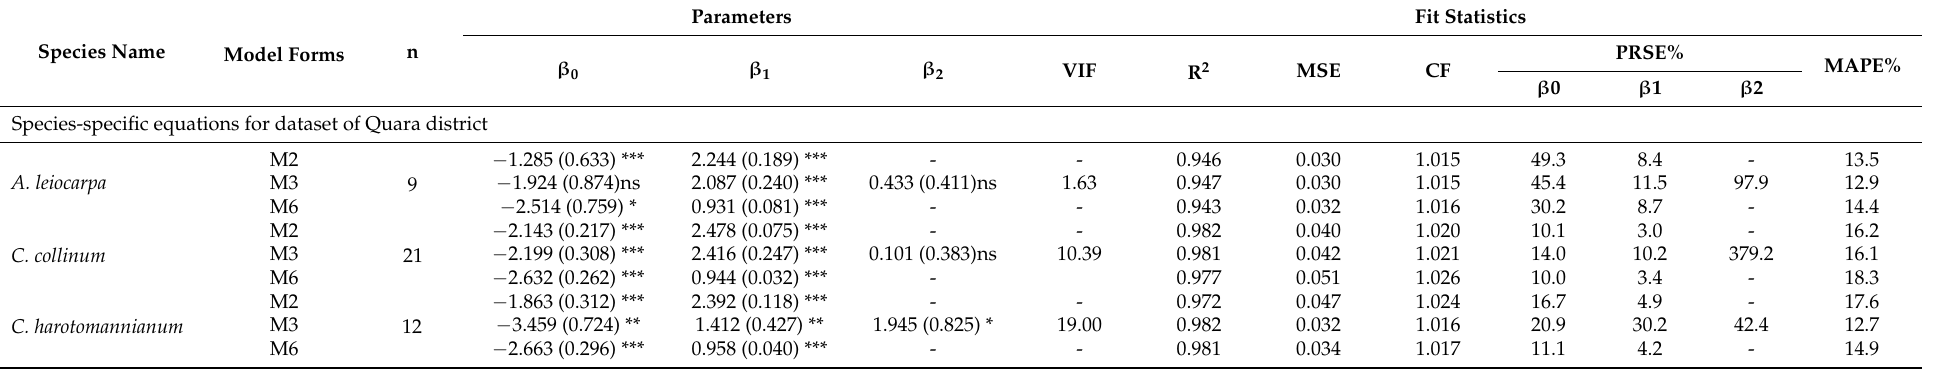
Table A2. Species-specific models with their parameters (and standard errors) and fit statistics of the species in the Combretum-Terminalia woodlands (CTW). The abbreviations in the table are defined in Section